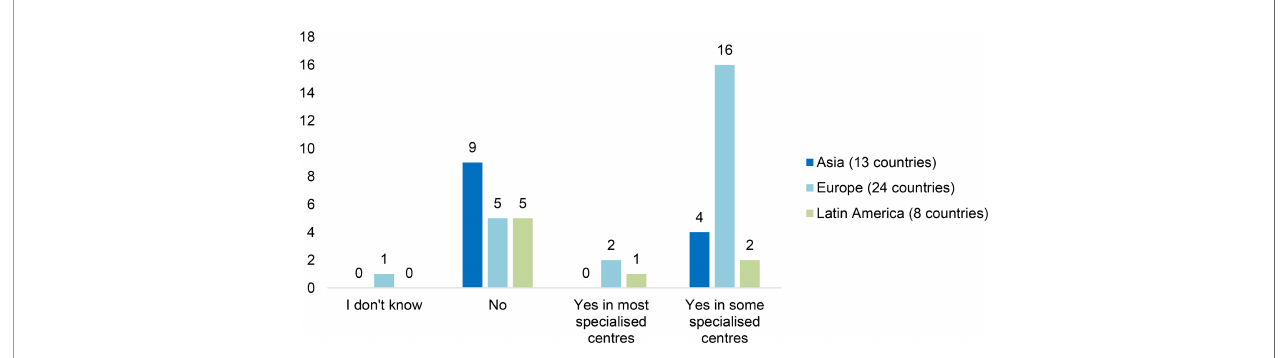
FIGURE 10 | Availability of transition care specialist services for PIDs by region (n=45).